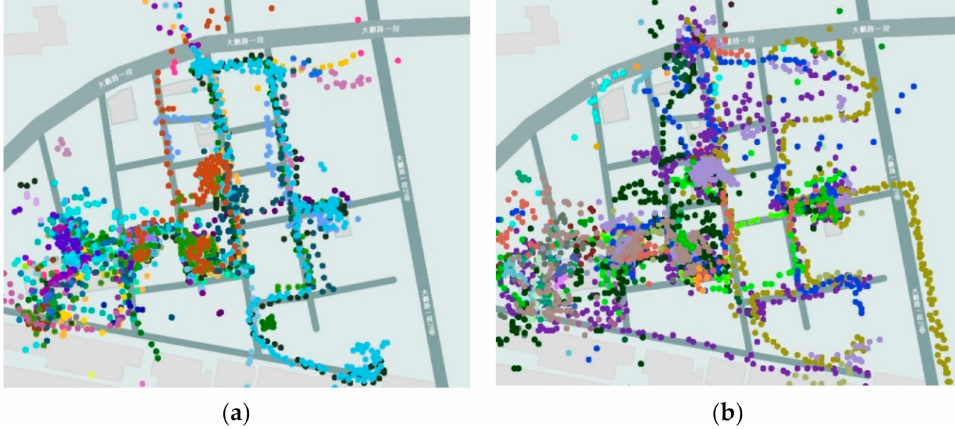
Figure 7. ( a ) Path distributions of participants using game mode (N = 54); ( b ) path distributions of participants using free mode (N =